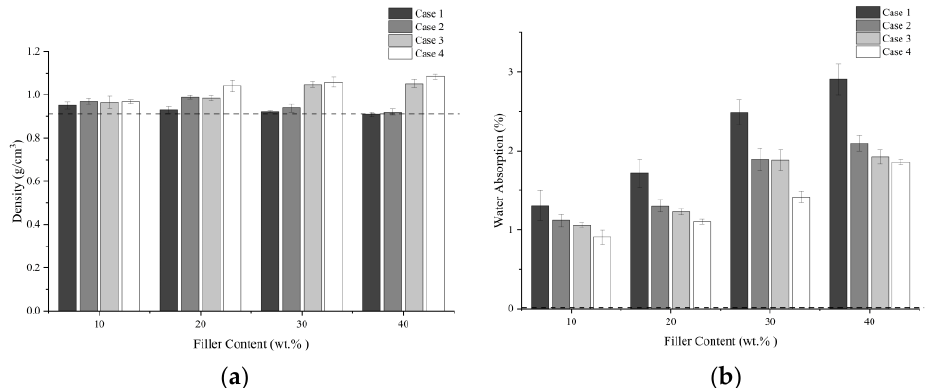
Figure 6. ( a ) Density and ( b ) water absorption of developed biocomposites (The dashed line represents the characteristics of LDPE).